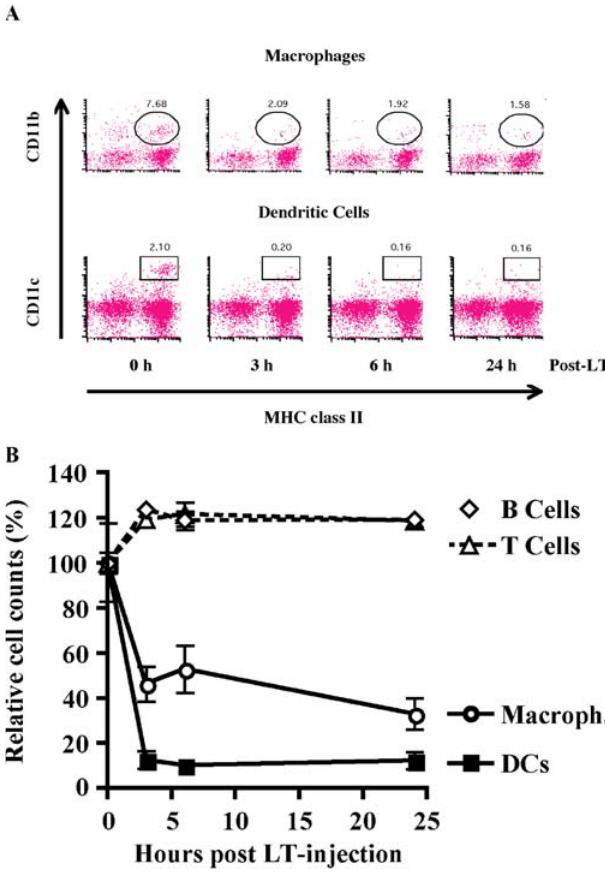
Figure 7. In Vivo Depletion of DCs and Loss of T Cell Activating Function Following LT Exposure (A) Murine DCs and macrophages are killed by LT in vivo. Ten-week-old BALB/c mice were injected intraperitoneally with LT, and the percentage of DCs and macrophages in the spleen were determined by flow cytometry. A representative experiment is shown. (B) Specific depletion of DCs and macrophages in LT-treated BALB/c mice injected intraperitoneally with either PBS or LT (200 l g PA and 200 l g LF). Levels of splenic DCs (CD11c þ , MHC class II þ ), macrophages (CD11b þ , MHC class II þ ), and circulating B cells (B220 þ ) and T cells (CD3 þ ) were determined by flow cytometry. Percent changes are shown by number of cells derived from LT-treated BALB/c mice (three mice per time point), relative to PBS-treated control mice (three mice per control experiment). DOI: 10.1371/journal.ppat.0010019.g007